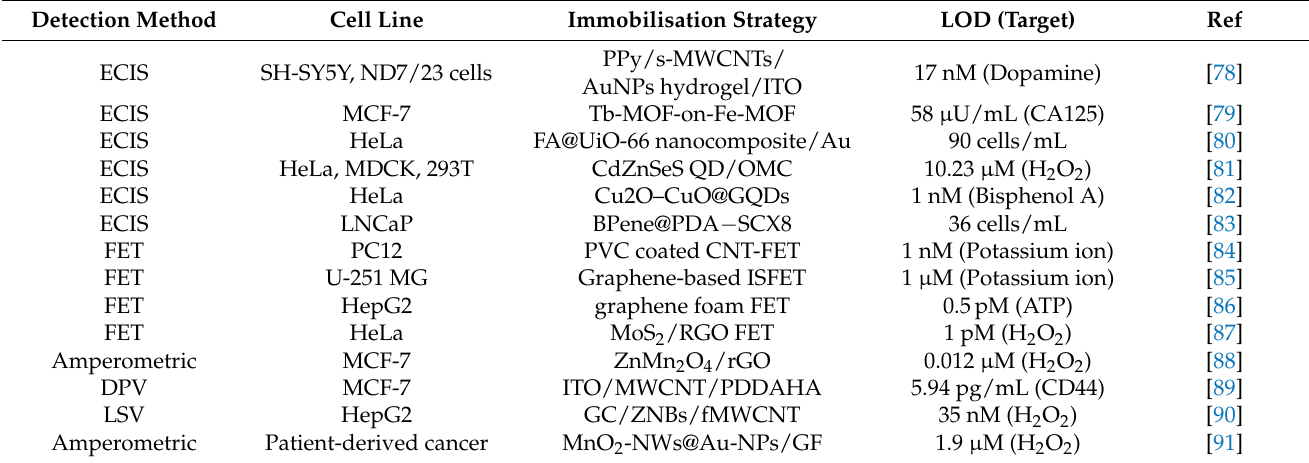
Table 1. Various types of electrochemical biosensors for live-cell